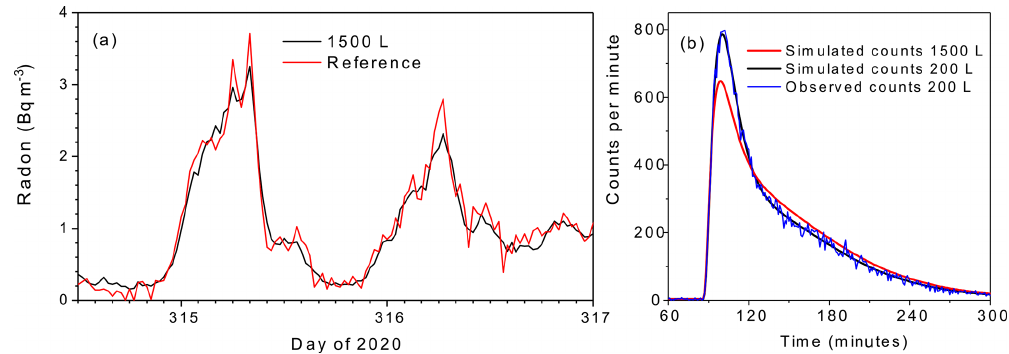
Figure 14. (a) Expanded view of direct comparison between the reference and 1500L monitors at 30min temporal resolution, and (b) nor- malised simulated response of the reference and 1500L monitors to a 1min radon injection.